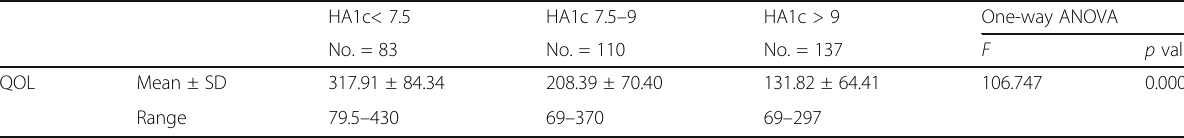
Table 6 Relation between HbA1C and quality of life of adolescent patients HA1c< 7.5